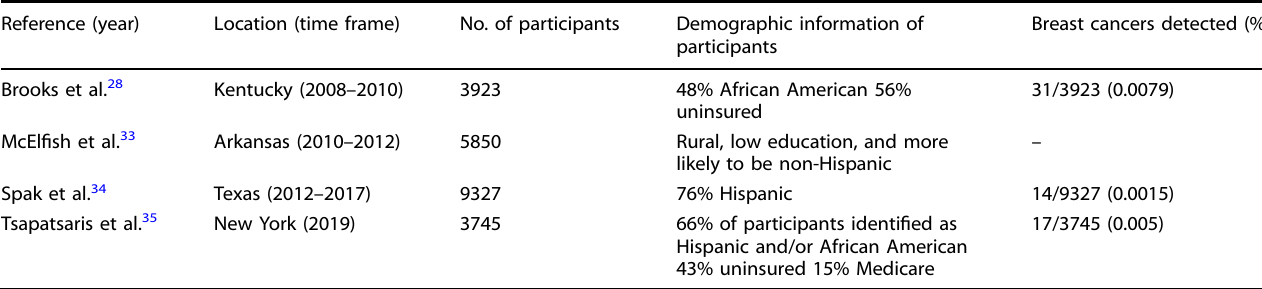
Table 4. Current literature addressing mobile mammogram screening in the United